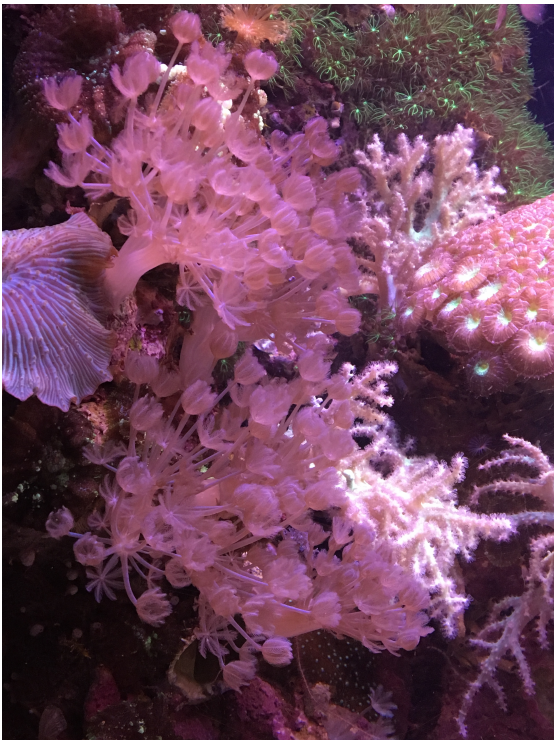
Fig. 1: Xeniid coral colonies at the Underwater Observatory, Eilat,